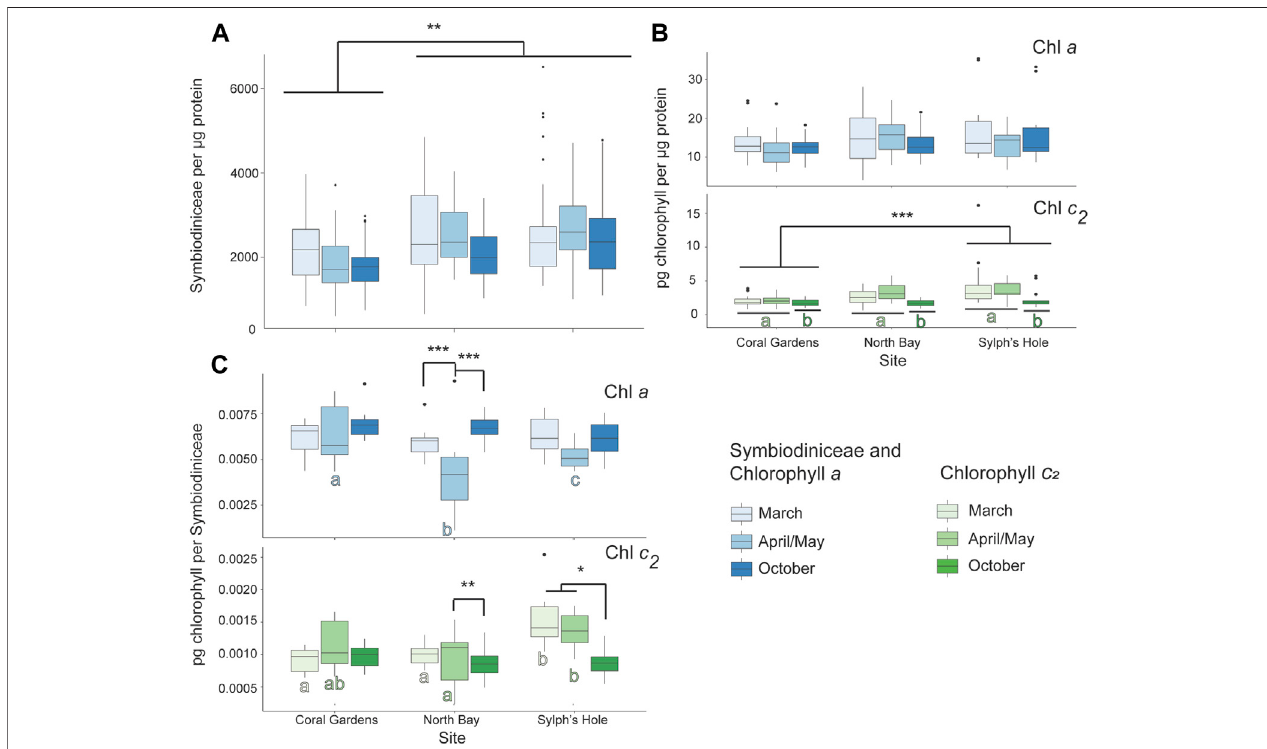
FIGURE8| Marineheatwaveeffectsonunbleached Cladiella sp.2acrossthreereefsintheLordHoweIslandlagoon. (A) Symbiodiniaceaedensityperµgproteinin unbleached Cladiella sp.2colonies duringMarch, April/May, and October. (B) Chlorophylla(above)and c 2 (below) densities per µgproteininunbleached Cladiella sp.2 colonies during March, April/May, and October. (C) Chlorophyll a (above)and c 2 (below) densities per µgprotein in visually healthy Cladiella sp. 2colonies during March, April/May, and October. Signi fi cance is designated either by different letter group or by a bar. p -values are represented as follows — * for p < 0.05, ** for p < 0.005, and ***for p < 0.0005. Where more than one plotisgrouped together, the highest p -value isreported. Bars above the boxplots represent monitoring interval differences within site, and letters below the boxplots represent site differences within monitoring